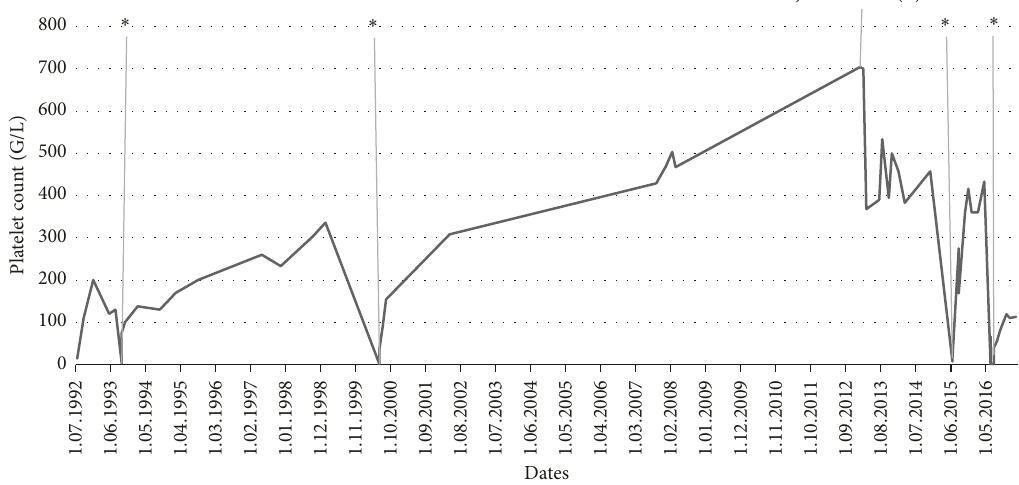
Figure 2: Kinetics of a platelet count during the follow-up of ITP-ET patient. ∗ ITP